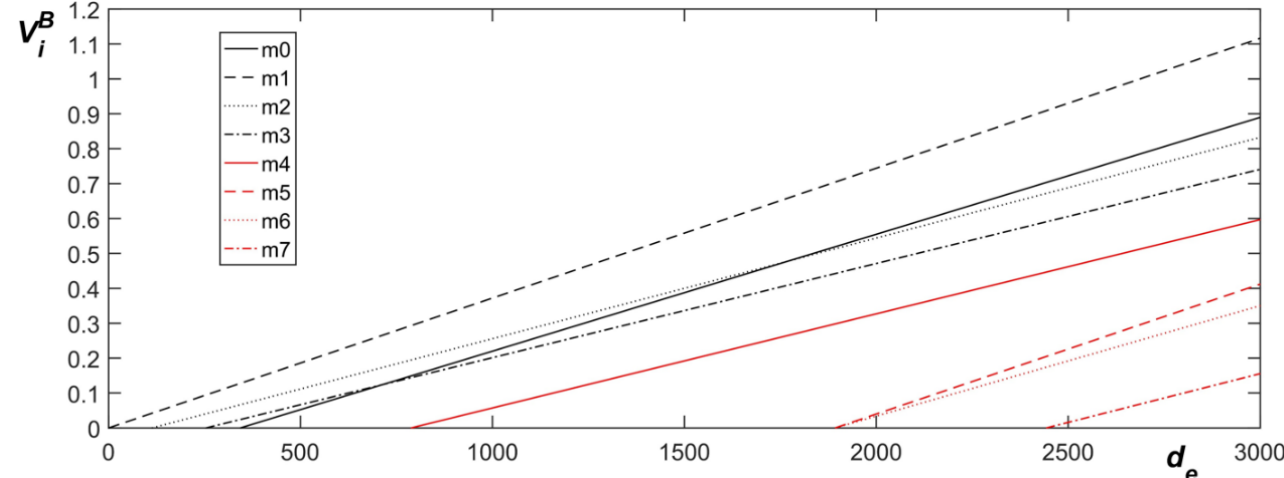
Figure 16. Bottleneck vulnerability delay and its evolutional curve.